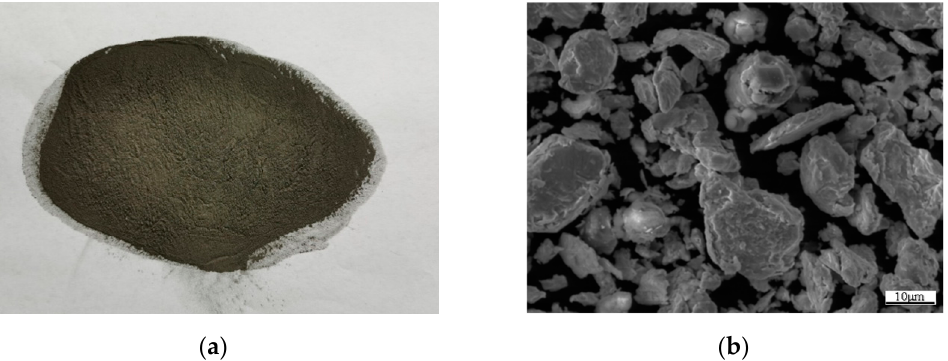
Figure 1. Mixed powder: ( a ) Macroscopic morphology of mixed powder; ( b ) SEM image of mixed